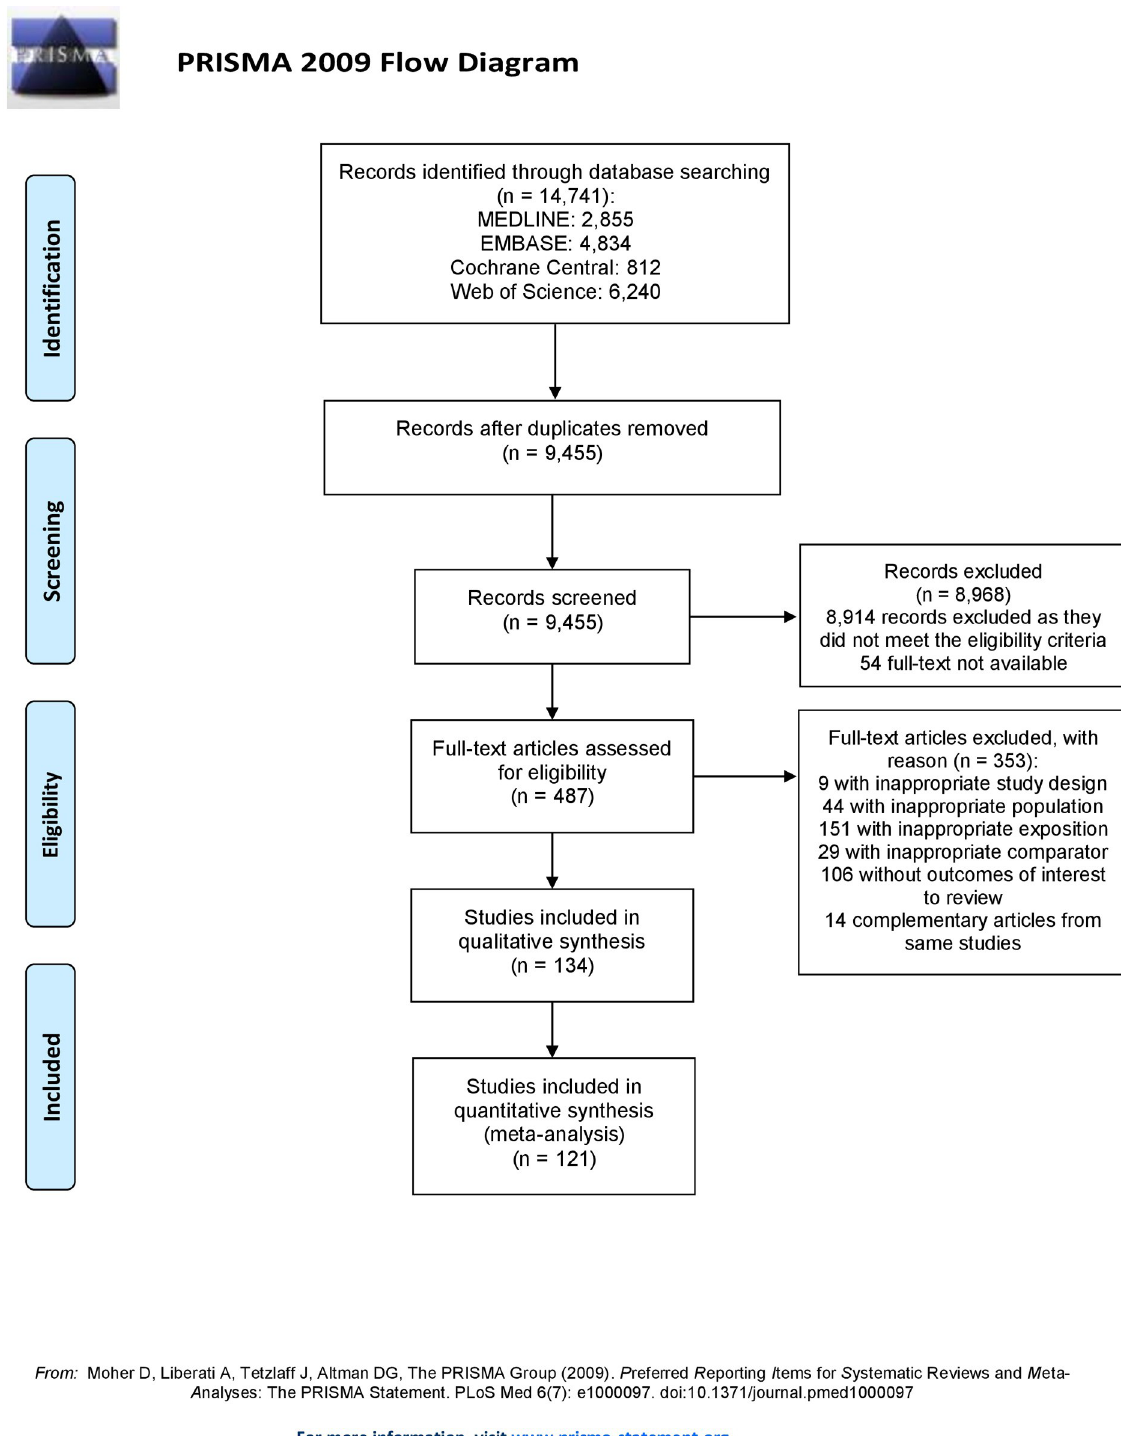
Fig 1. Flow chart of study selection process.